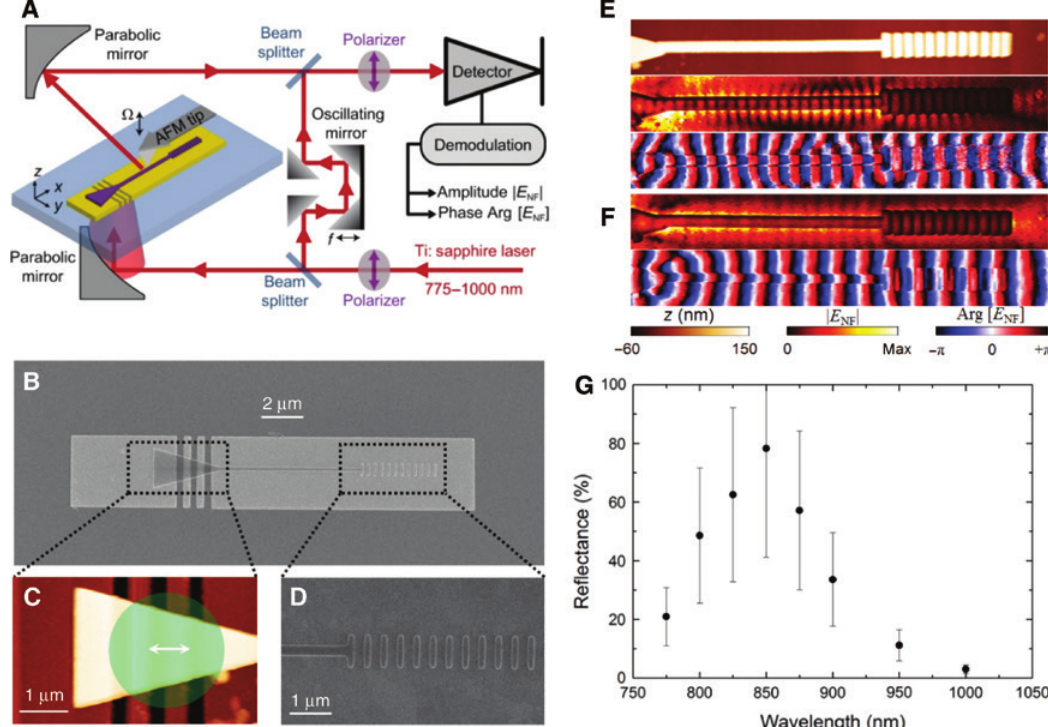
Figure 5: Near-field investigation of the unidirectional SPP coupler. (A) Schematic of the near-field optical setup. (B) SEM image of the fabricated device, namely dielectric nanoridge atop a patterned gold rectangular layer. (C) AFM image of the input grating, overlapped with dielectric funnel for excitation of dielectric-loaded SPP mode. Green circle and white arrow illustrate the approximate position of incident illumination spot (not to scale) and its polarization, respectively. (D) Zoomed-in SEM image of RBG. (E, F) Topography z (top), near-field amplitude | E unidirectional SPP coupler, recorded at λ = 850 nm (E, inside the TM bandgap) and λ = 1000 nm (F, outside the TM bandgap). (G) Reflectance of RBG, evaluated from SNOM